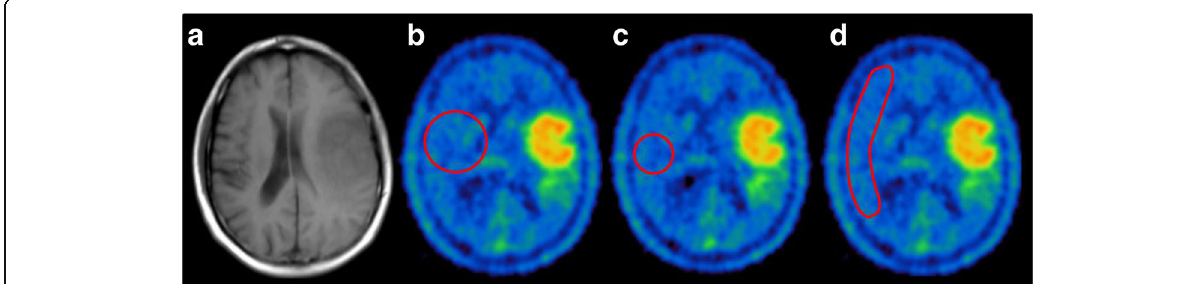
Fig. 2 Examples of the different methods of background assessment. a T1 MRI for morphological correlation. The three different methods of background activity assessment are featured using b a 2D-ROI in the contralateral hemisphere with 5 cm diameter as example (as suggested in the German guideline), c a spherical VOI with 3 cm diameter, and d a crescent-shaped VOI